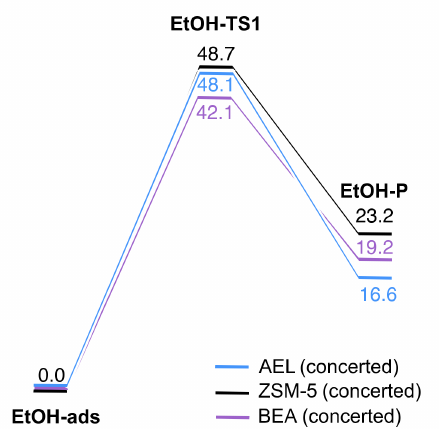
Figure 6. Energy values, ∆ E (kcal mol − 1 ), are reported along the concerted reaction pathway proposed for ethanol (EtOH) dehydration in H-ZSM-5 [22], H-BEA, and H-AEL. All values were calculated using ONIOM (M06-2X / 6-311G(d,p):PM6). “EtOH-ads” refers to the ethanol substrate adsorbed at the chosen active site of the respective catalyst. The concerted pathway was consistently a comparable or lower-energy path than the stepwise mechanism